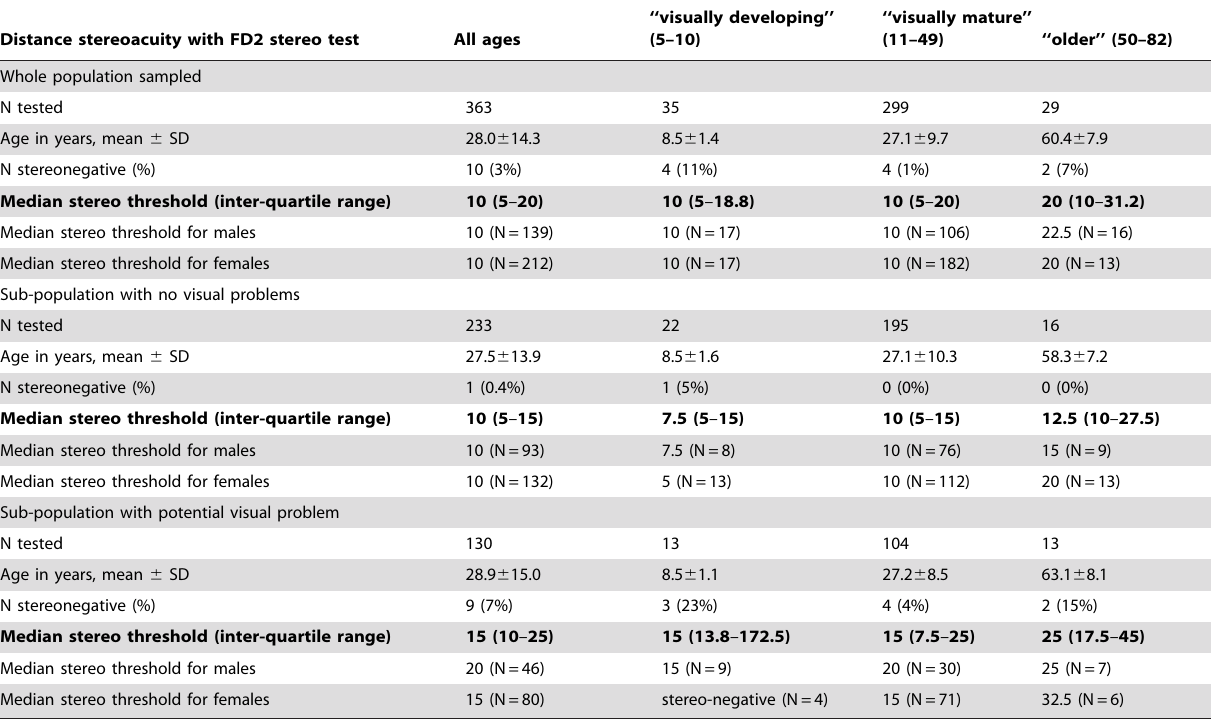
Table 2. Stereo thresholds on the FD2 test (in seconds of arc).